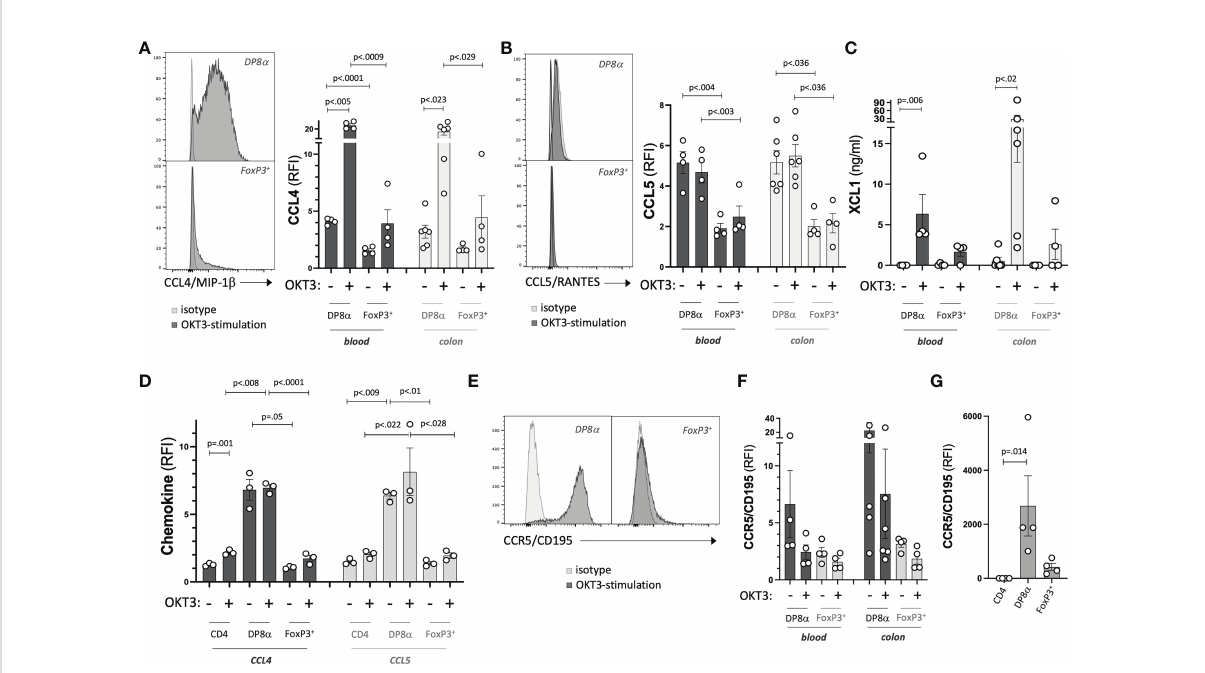
FIGURE 6 Chemotactic potential of DP8 a Tregs. (A - C) Expression of indicated chemokines by representative Treg clones (left) and all studied Treg clones (right). (D) Expression of CCL4 and CCL5 by PBMCs from 3 HD shown for indicated gated T cell subsets. (E - G) Expression of CCR5 by representative Treg clones (E) , all Treg clones (F) and gated subsets from PBMCs (G) . Paired 2-sided t-tests were used for single comparisons, while one-way ANOVA followed by Dunn ’ s multiple comparison tests were performed for 6A-D,G, p<.05 was considered statistically signi fi